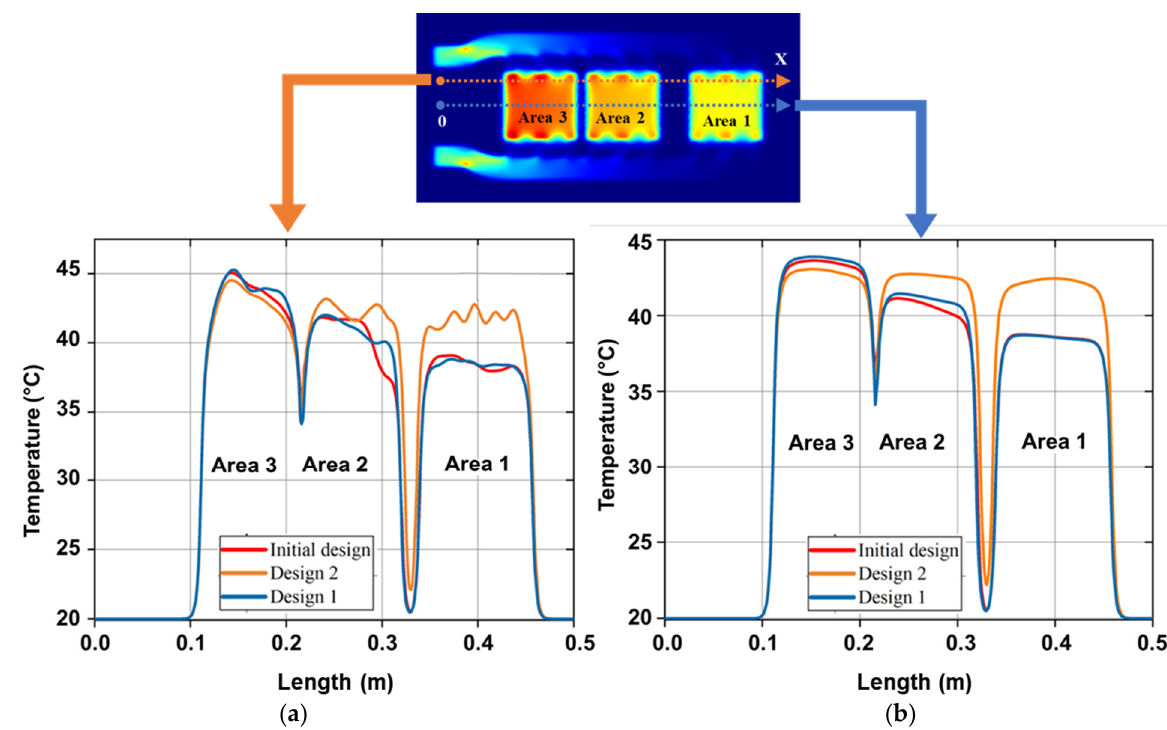
Figure 8. Temperature evolution along the x-axis: ( a ) lateral temperature and ( b ) central tempera- ture.